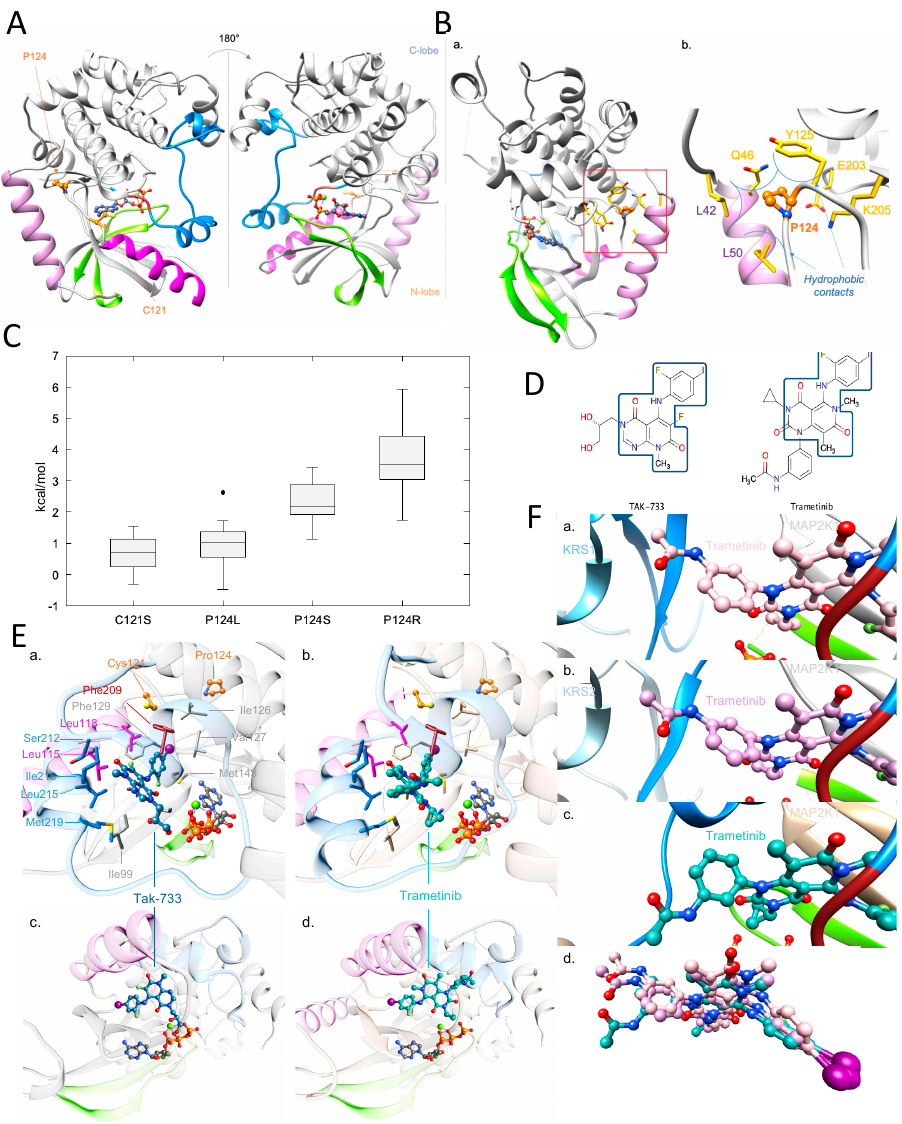
Figure 2. Molecular modelling analysis: ( A ) Representation of the MAP2K1 kinase structure in the presence of the ADP and the Mg 2+ in ball-&-stick. The P-loop is coloured in green, the C-helix in magenta, the A-loop in blue, the Helix-A in pink and the DFG motif in dark red. Cys121 and Pro124 are in orange ball-&-stick (pdb: 3eqi) [17]; ( B ) MAP2K1 Pro124 environment. ( a ) Kinase structure; ( b ) Zoom on MAP2K1 Pro124, represented in orange ball-&-stick, and its neighbour residues in a sphere of 5Å, represented in sticks and coloured in yellow. MAP2K1 kinase structure is in the presence of the ADP and the Mg 2+ in ball-&-stick. The P-loop is coloured in green, the C-helix in magenta, the A-loop in blue, the helix-A in pink and the DFG motif in dark red. (pdb: 3eqi)